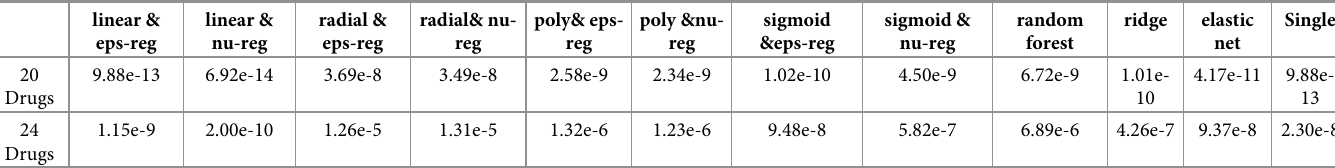
Table 5. p -values produced by the paired t -test for each of the competitive methods versus the mixture